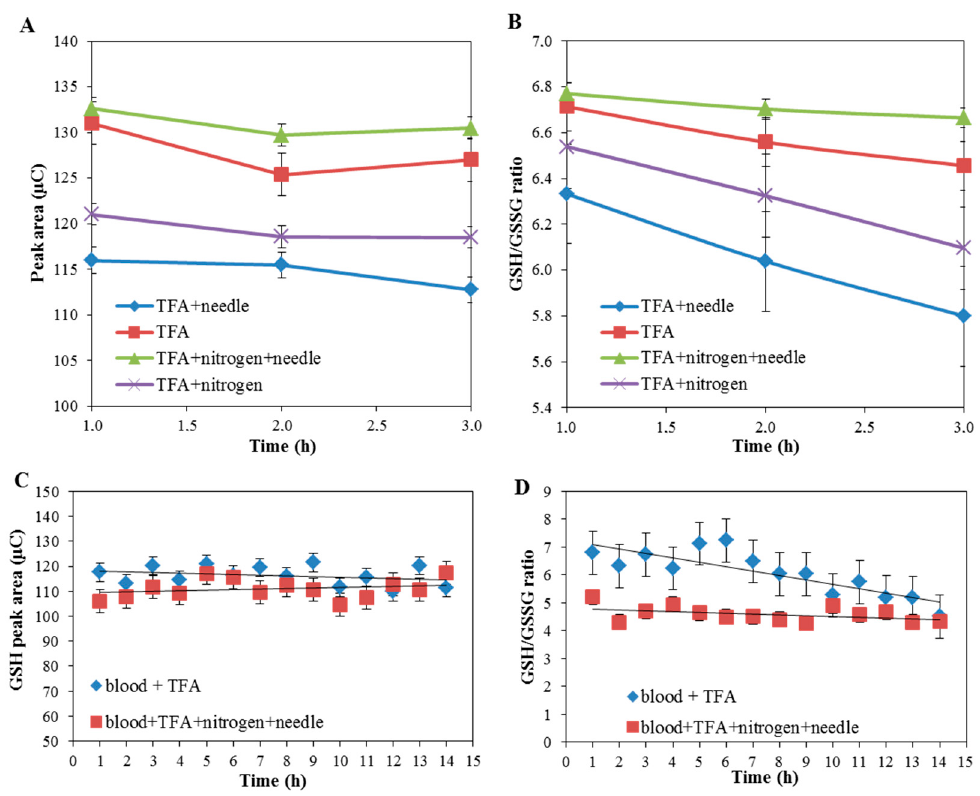
Figure 1. The effect of sample preparation on glutathione (GSH) signal ( A , C ) and on the ratio of GSH to oxidized, dimeric glutathione (GSSG) ( B , D ) over a certain amount of time. Values are means of three replicates (n = 3). Vertical bars indicate standard error.